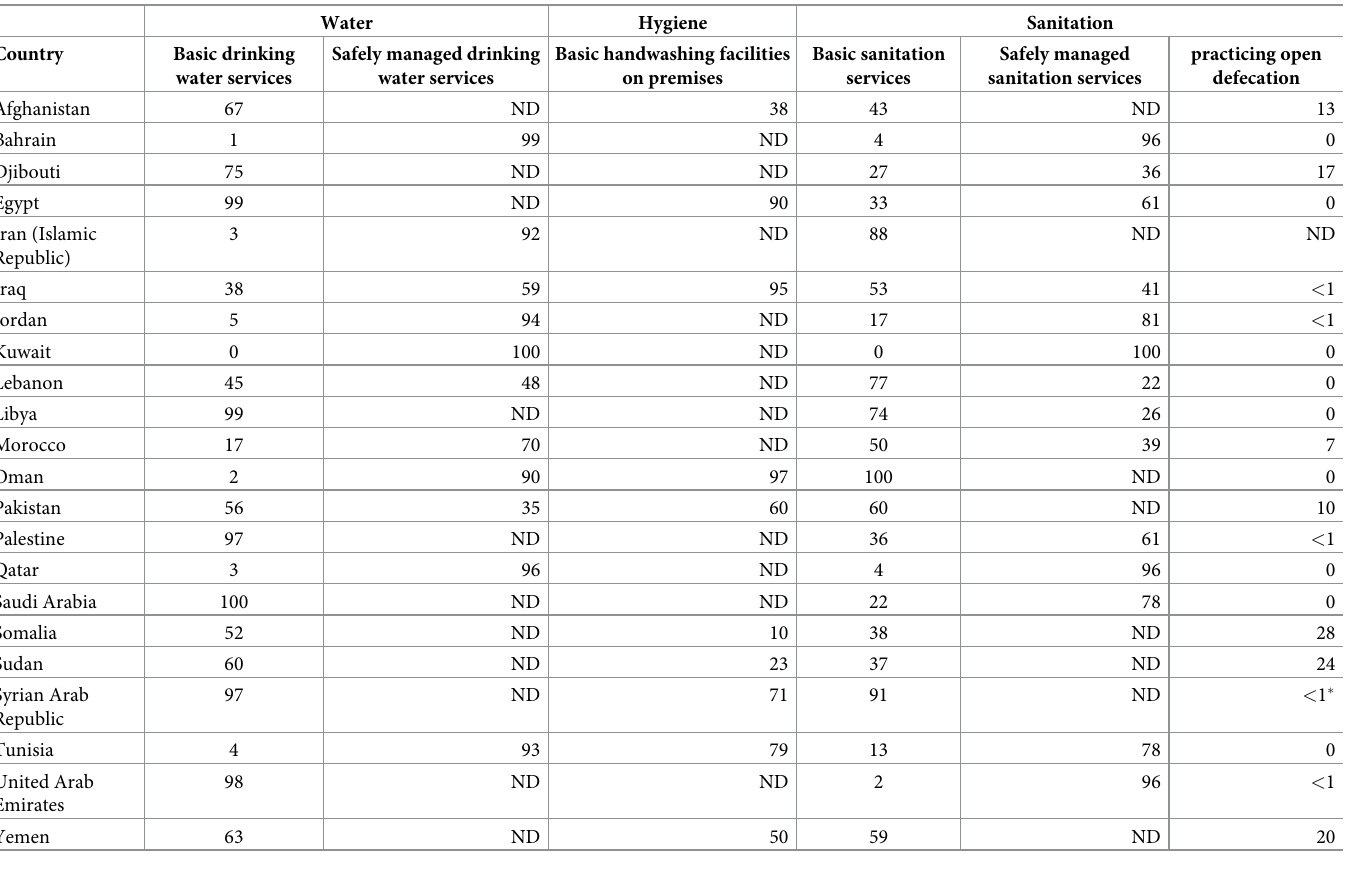
Table 5. Percentage populations with access to safe water and appropriate sanitation, Global Indicator Data Platform for Sustainable Development Goals,